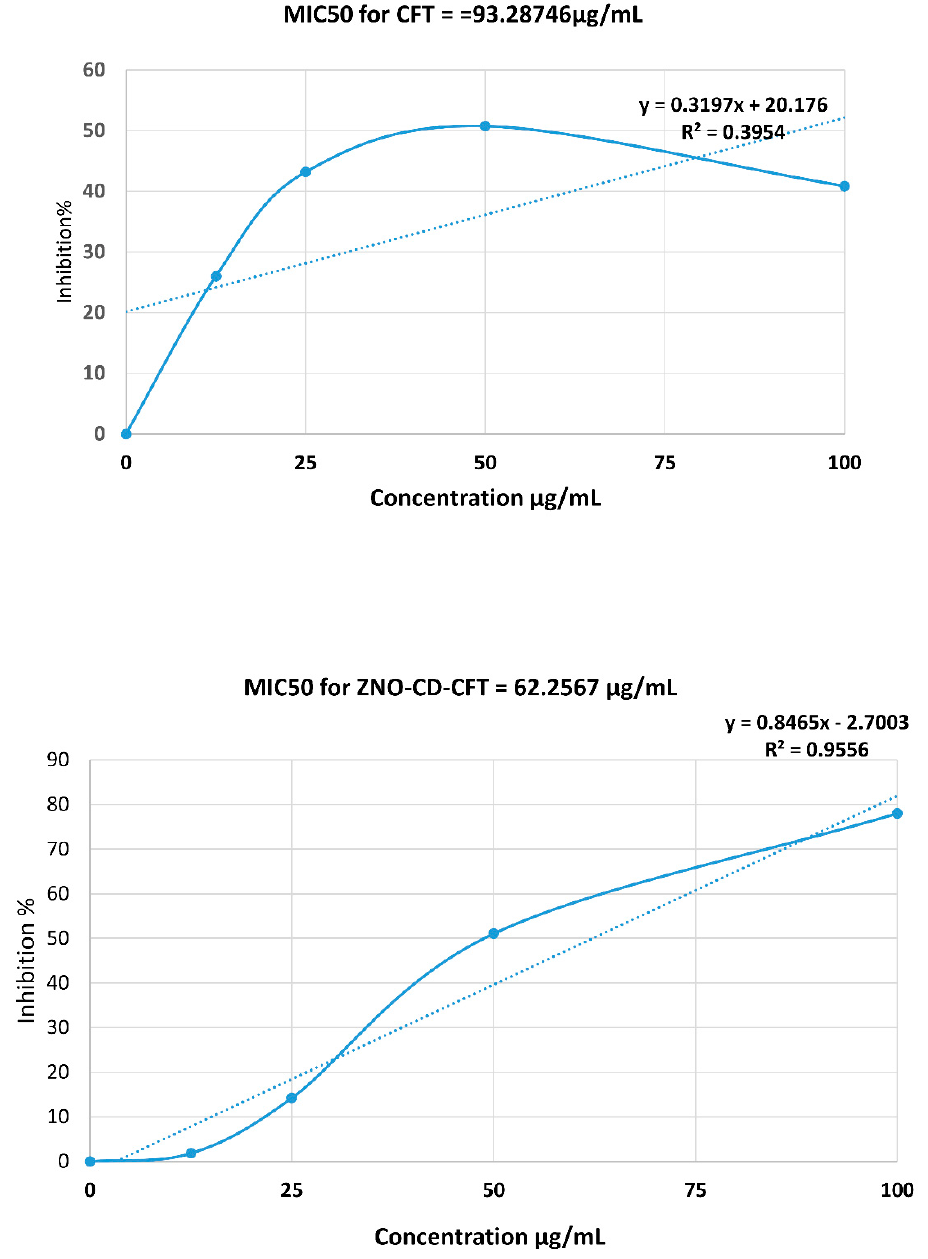
Figure 3. The MIC 50 values of the CFT and ZnO-CD-CFT for amoebistatic activity were determined using the following concentrations: 50, 75, and 100 μ M. The MIC 50 values for the CFT and ZnO-CD-CFT were 101.9 μ g/mL and 74.64 μ g/mL, respectively. The results are presented as the mean ± standard error.